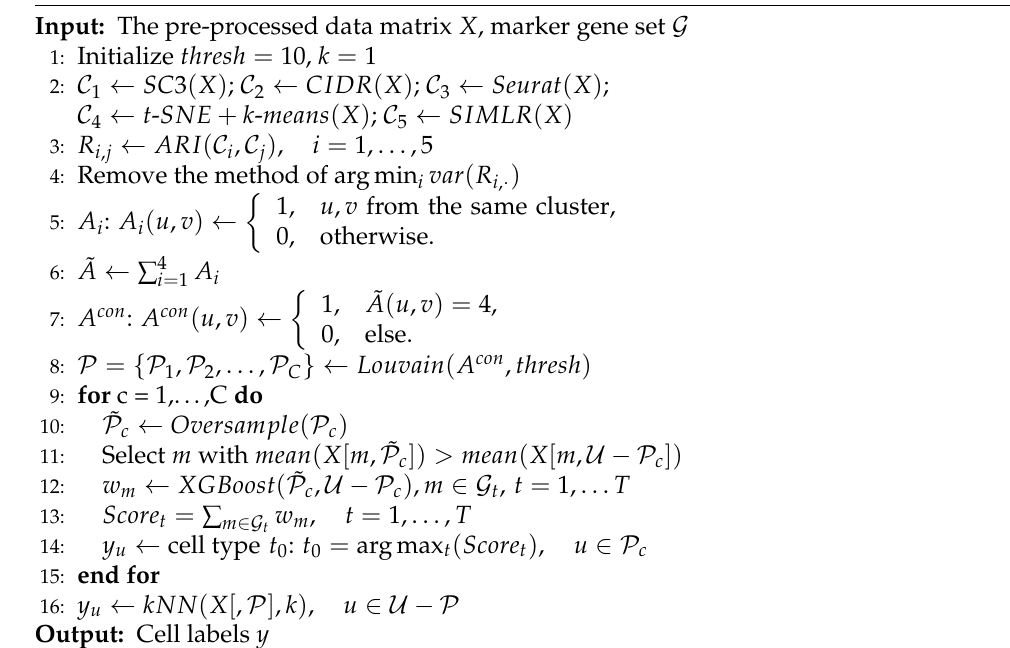
Algorithm 1 ACAM: Automatic Cell type Annotation